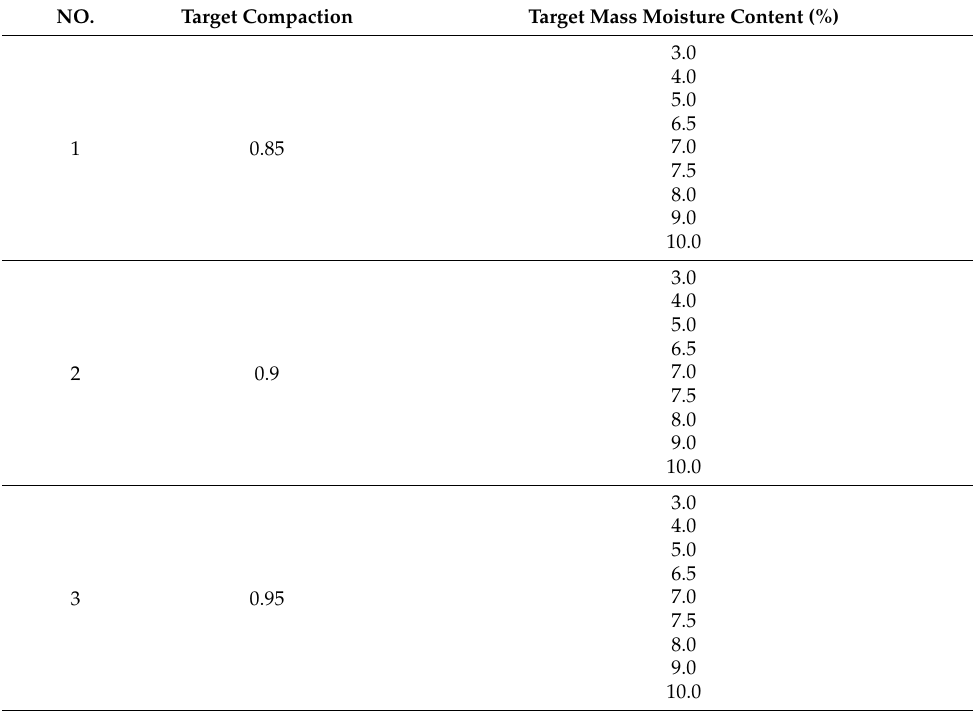
Table 1. Target value of compaction test.